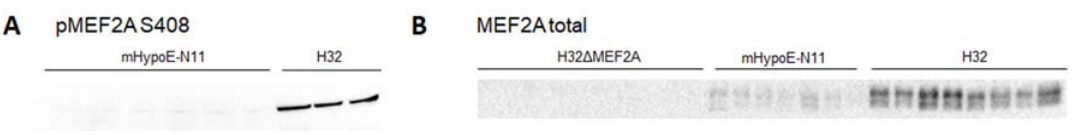
Figure A3. ( A ) and ( B ) Characterization of pMEF2A S408 and MEF2A total in mHypoE-N11, H32 ∆ MEF2A and H32 cells.